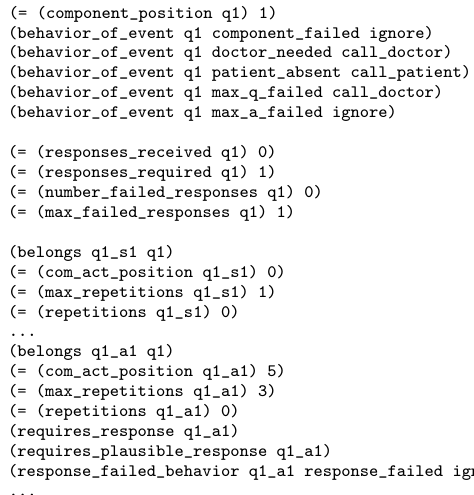
Figure 7. Fragment of problem definition for Bathel test. First question (component q1